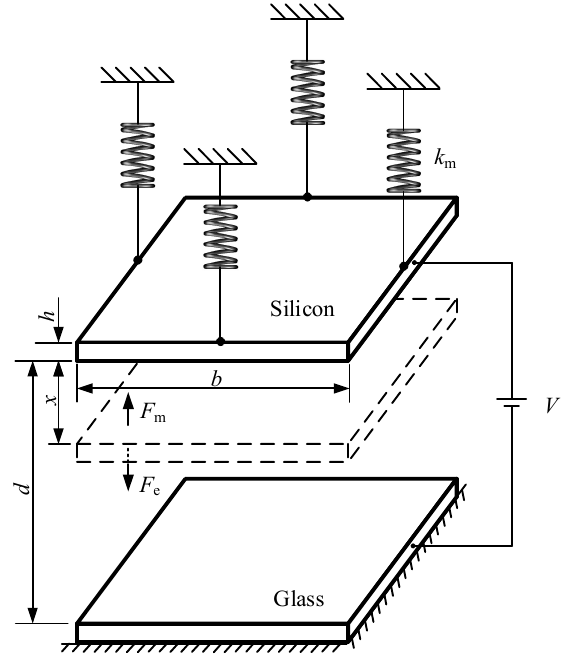
Figure 2. Force analysis of the silicon diagram during anodic